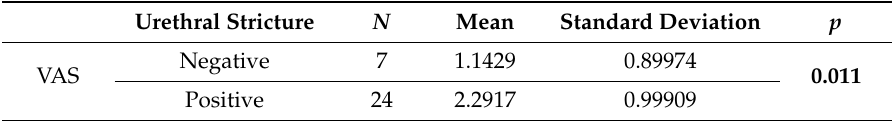
Table 4. Distribution of VAS scores according to urethral stricture.